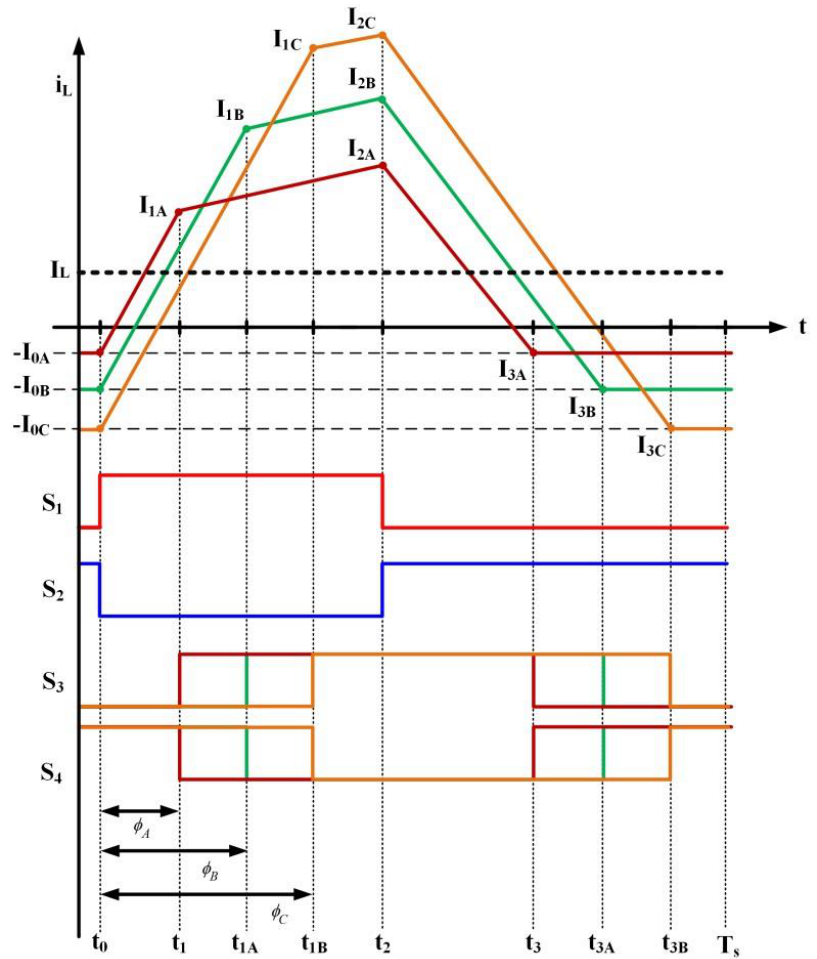
φ (other operating conditions